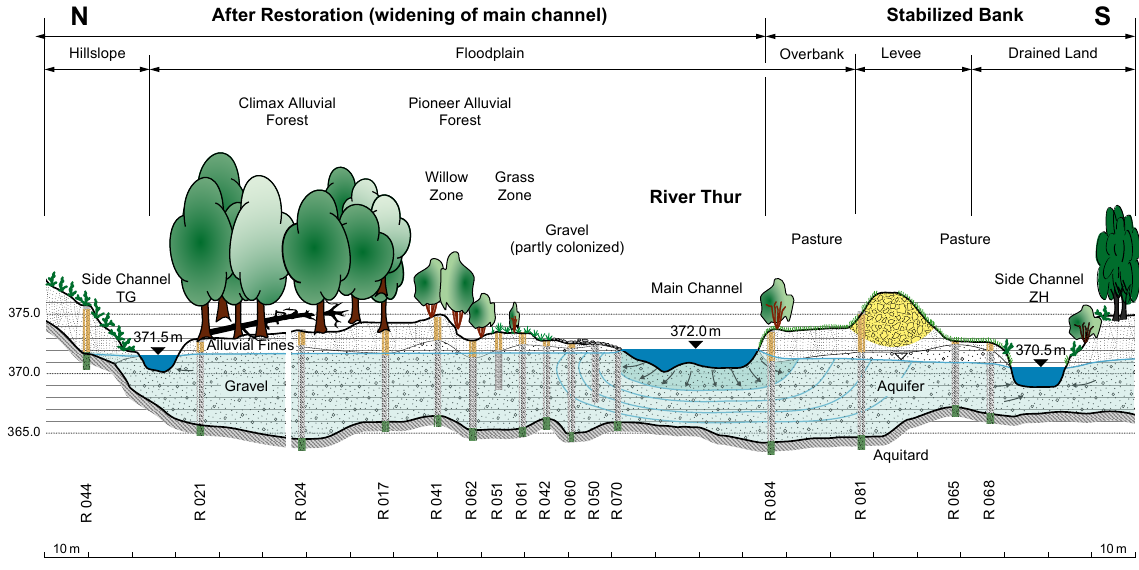
Fig. 3. Geological cross-section representing restored (left; R044 to R070 forming transect B in Fig. 2) and channelized (right; R084 to R068 forming transect E in Fig. 2) transects at the test site Neunforn. The restored parts comprises gravel bars developed naturally after restoration in 2002 – including the gravel zone, sparsely colonized with pioneer plants, and the grass zone characterized by thick layers of young alluvial overbank sediments densely colonized with mainly reed grass ( Phalaris arundinacea ) – the willow zone where older alluvial sediments were stabilized during restoration by planting young Salix viminalis , and the alluvial forest dominated by ash and maple growing on older alluvial